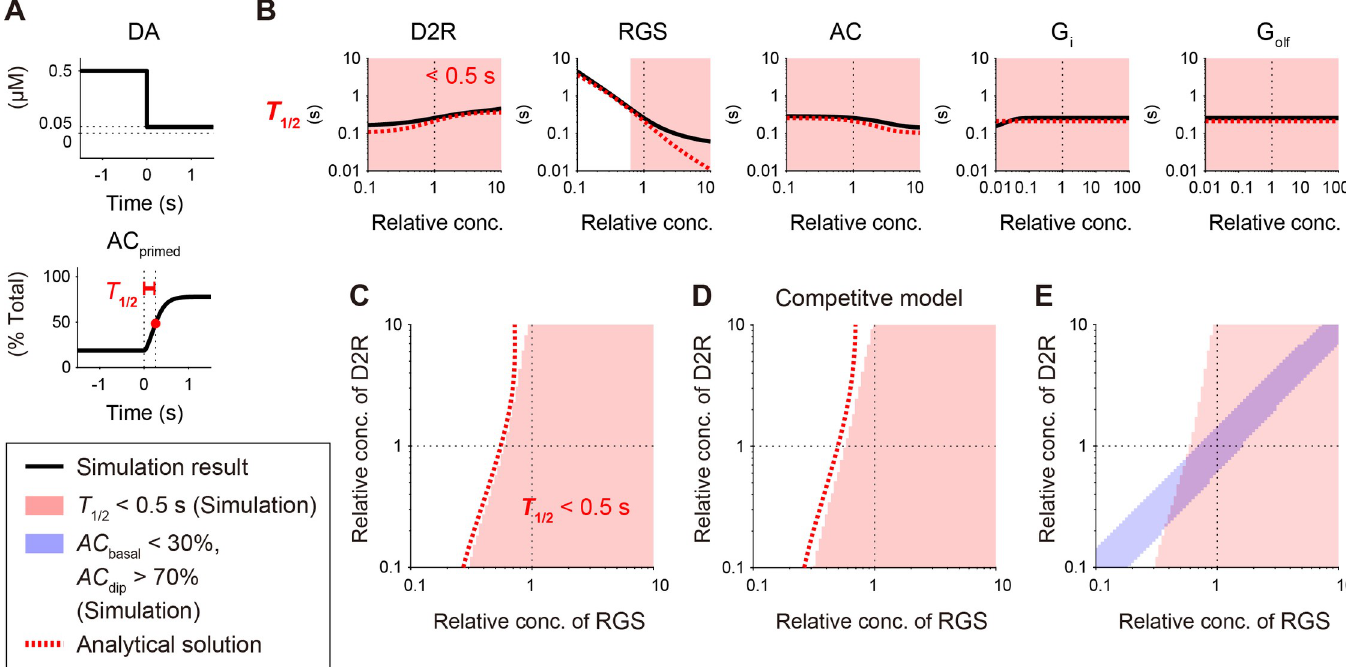
Fig 4. DA dip detection requires a certain concentration of RGS. (A) The third measure to quantify DA-dip detectability. Sudden decrease in the basal DA signal disinhibits AC with a half-maximal time, T 1/2 , which needs to be small for detection of a short (~0.5 s) DA-dip. (B) Concentration dependence of T 1/2 . Five molecules were targeted, and the simulation results (black solid lines) and analytical solutions (red dotted line, Eq (24)) were plotted. T 1/2 < 0.5 s were highlighted in pink as the region that allows detection of the DA dip. (C) T 1/2 < 0.5 s (pink) in the space of [ D2R ] tot and [ RGS ] tot . (D) Same as panel C, but the DA model was based on the competitive binding between G olf and G i (See S1 and S2 Figs ). (E) The area of T 1/2 < 0.5 s (pink shaded area in (C)) was overlapped with the region that satisfies both AC basal < 30% and AC dip > 70% (blue shaded area). The ~0.5-s DA dips can only be detected in the overlapping